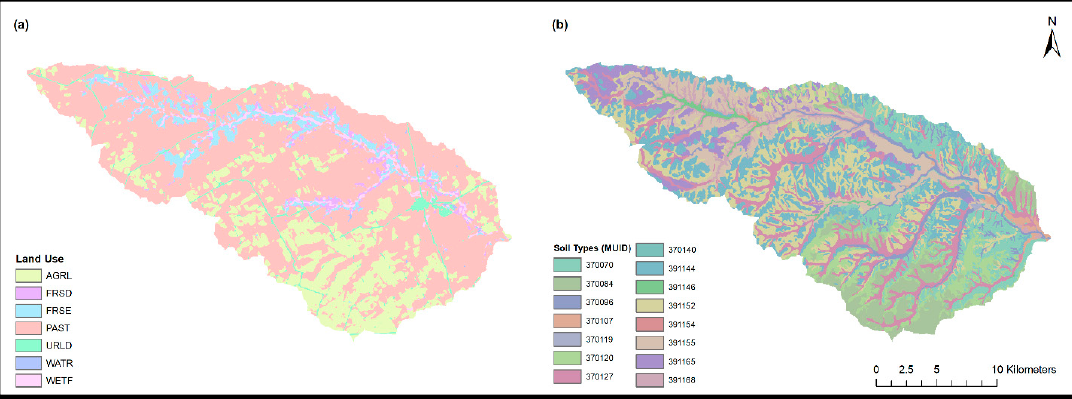
Figure 6. Geographical inputs for HRU definition in SWAT+: ( a ) land use; and, ( b ) soil types.